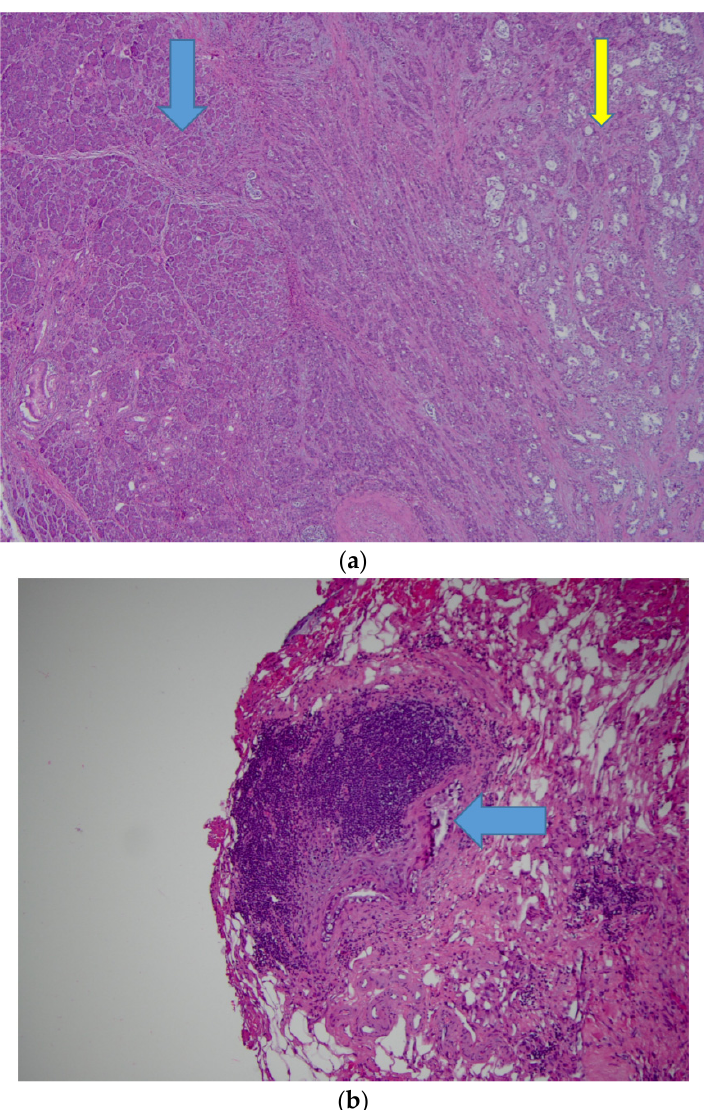
Figure 3. Ultrasound venous duplex imaging of the bilateral upper extremities shows echogenic, non- compressible material in the left cephalic vein, representing acute, non-occlusive thrombosis (white arrow), and also in the right cephalic vein in the distal arm (not shown).